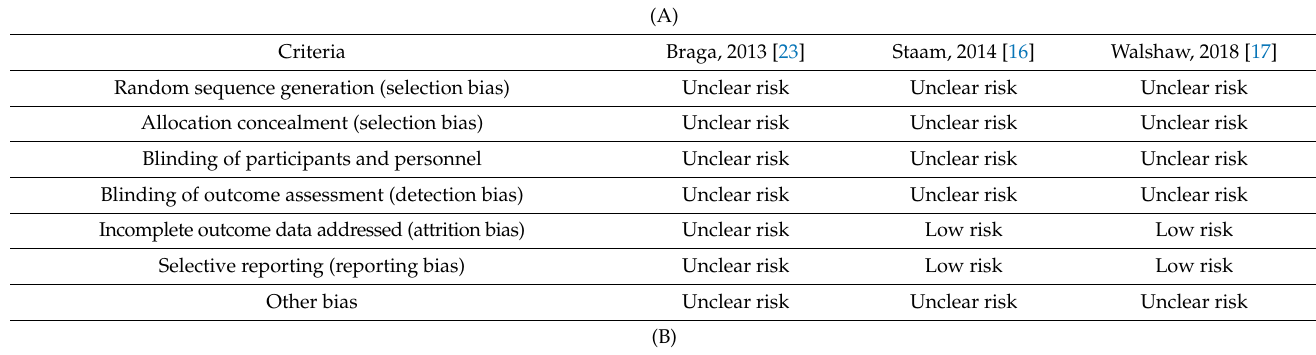
Table 2. (A): Risk of bias for RCTs included in the systematic review. (B): Quality assessment of the open-label studies included—Methodological Index for Non-Randomized Studies